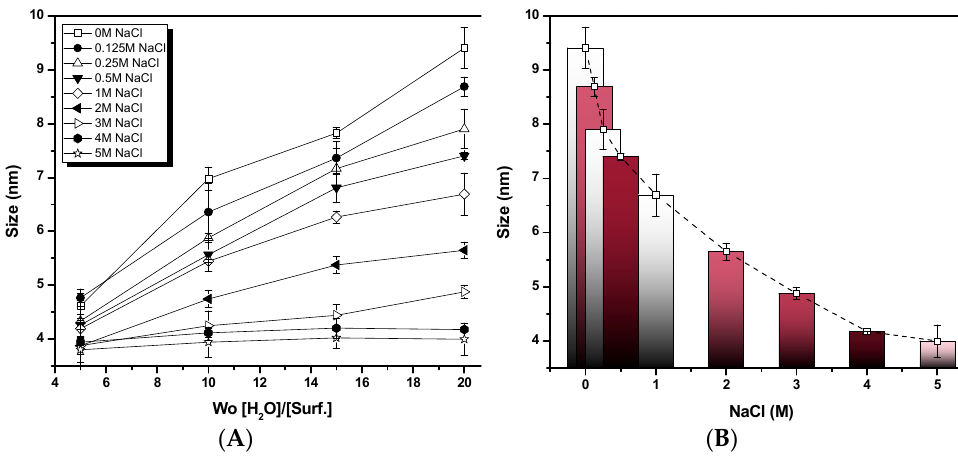
Figure 1. Average size distribution in AOT/ Water/ Isooctane reverse micelle systems. ( A ) Effect of aqueous content and NaCl concentration on the size of reverse micelles, ( B ) Size of reverse micelles as a function of NaCl concentration at Wo = 20.